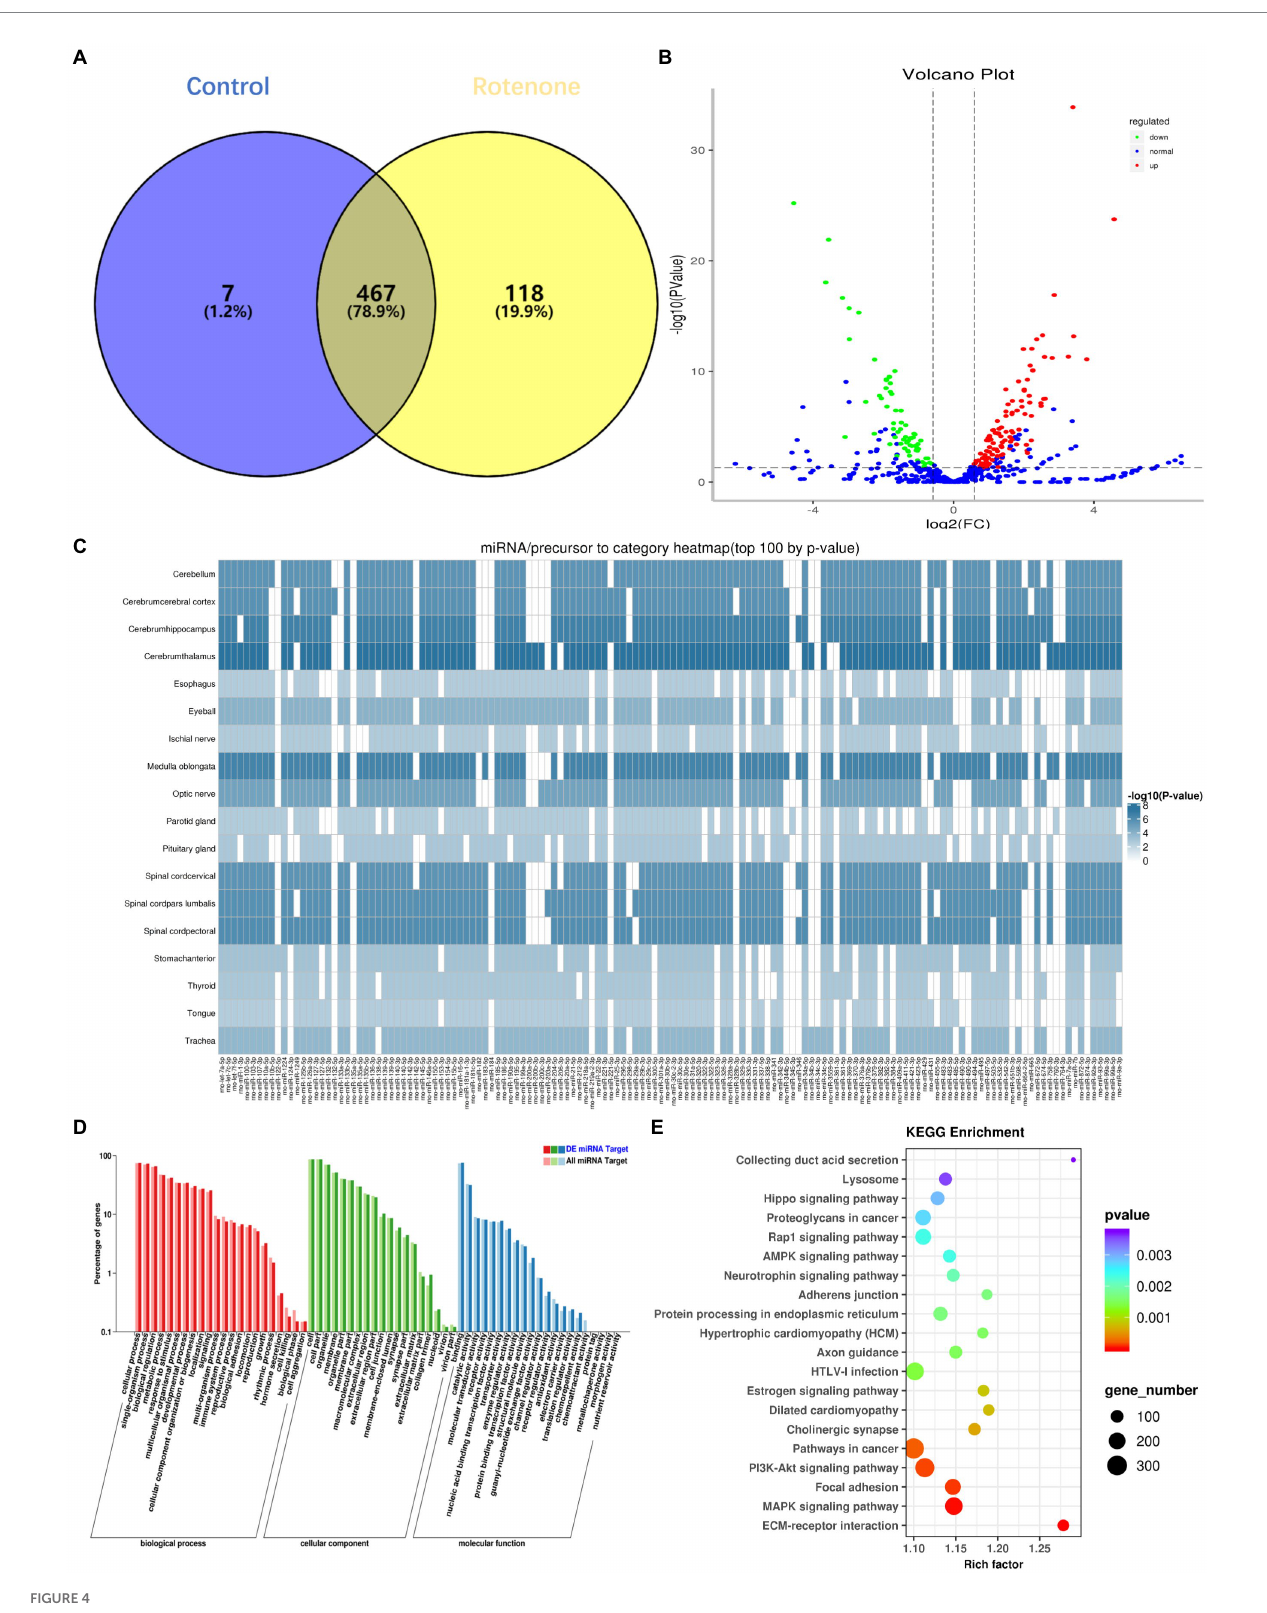
FIGURE 4 Differential microRNA (miRNA) expression between sham and Parkinson’s disease (PD) midbrain tissue–derived small extracellular vesicles (bdsEVs) and analysis of differentially expressed genes (DEGs) in PD bdsEVs. (A) The Venn diagram of 592 known mature miRNAs, (B) Volcano plot of differentially expressed miRNAs between sham and PD bdsEVs. The Y-axis of the graph represents significance ( − log10 of the value of p) and the X-axis represents log2 of the fold change (expression in PD bdsEVs/expression in sham bdsEVs). Red, significantly upregulated miRNAs; green, significantly downregulated miRNAs; blue, no significant difference. Fold change >1.5 (log2 FC > 0.58 or < − 0.58) and p < 0.05 ( − log10 ( p -value) > 1.3) were considered significant, (C) Heat map of differential top 100 miRNA precursor categories by p -value, (D) Gene Ontology (GO) enrichment analysis of CC, MF, and BP presenting the items of GO enrichment ( p < 0.05 and FDR < 0.05), and (E) Kyoto Encyclopedia of Genes and Genomes (KEGG) pathway analysis of the KEGG pathways of DEGs in the sham and PD groups ( p < 0.05 and FDR < 0.05). BP, biological processes; CC, cellular components; MF, molecular function; FDR, false-discovery